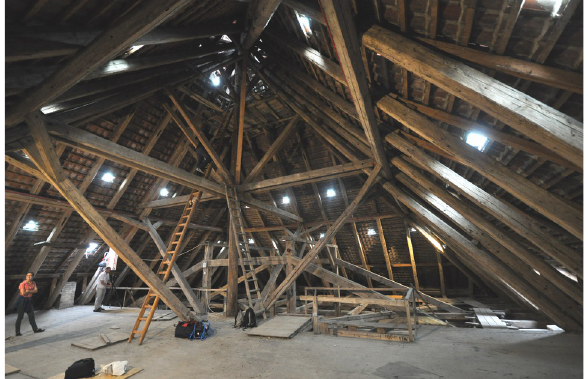
Figure 2. The pagoda-shaped timber structure during the operations of